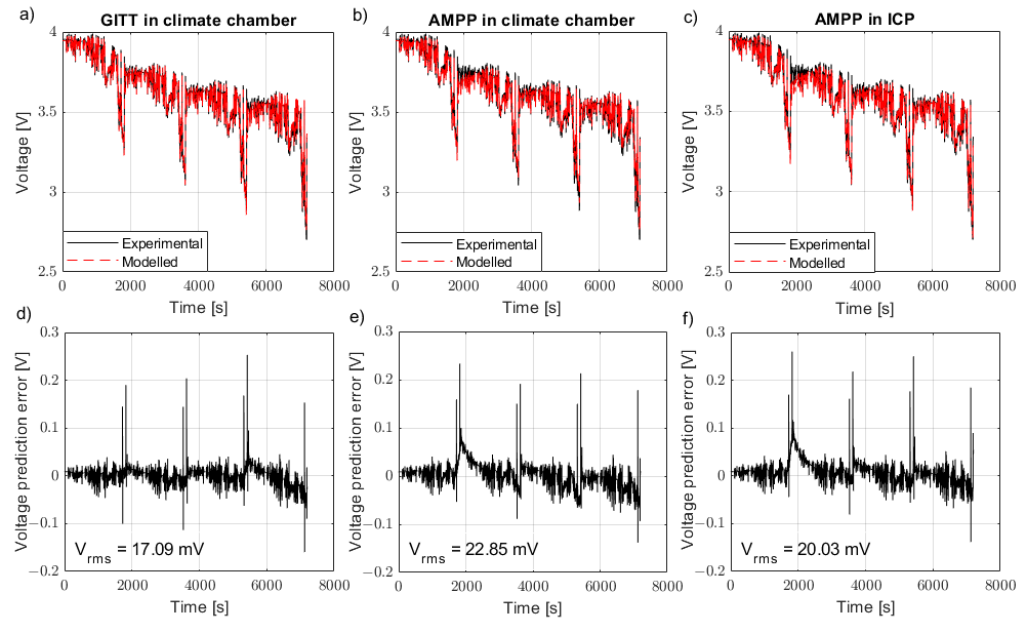
Figure 6. Drive cycle validation along with associated error for the model parameterised using the GITT data in the climate chamber, AMPP data in the climate chamber and AMPP data in the ICP at 25 °C. The comparison of the ECM to experimental drive cycle data is shown in subfigures ( a – c ), whilst their associated error is shown in subfigures ( d – f ).